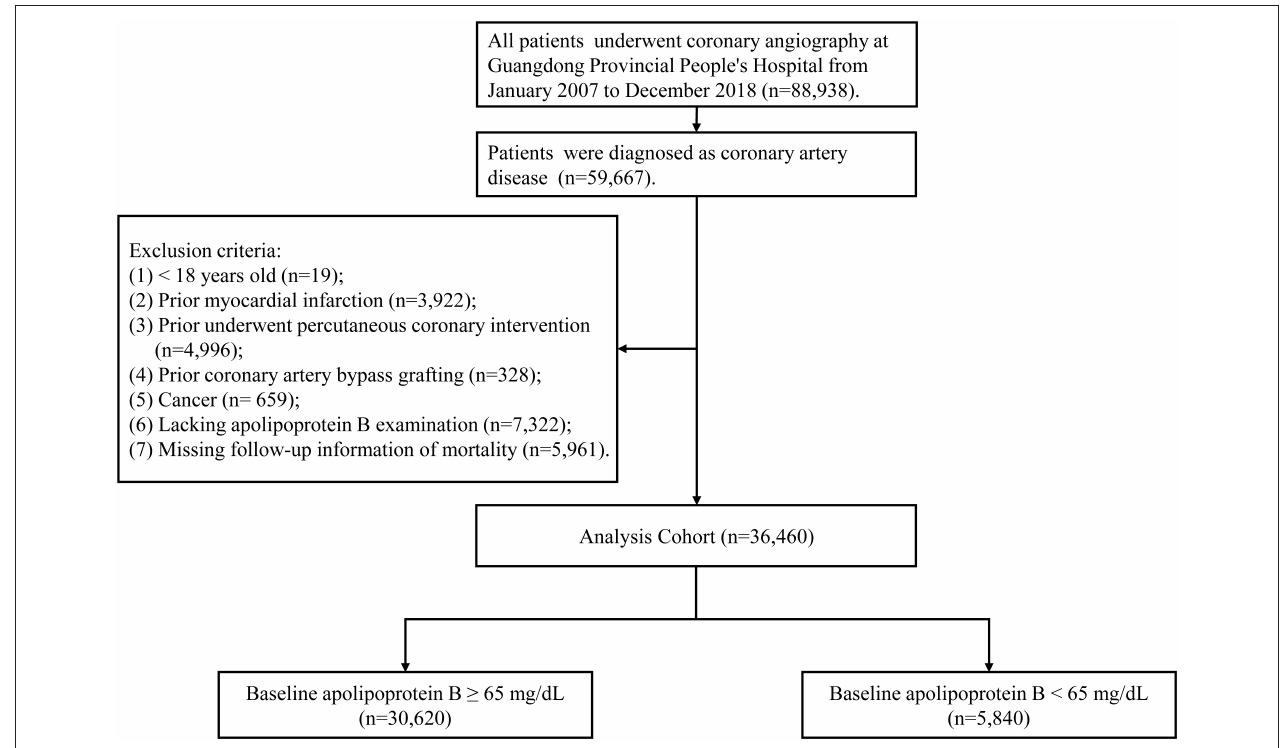
FIGURE 1 | Study flow